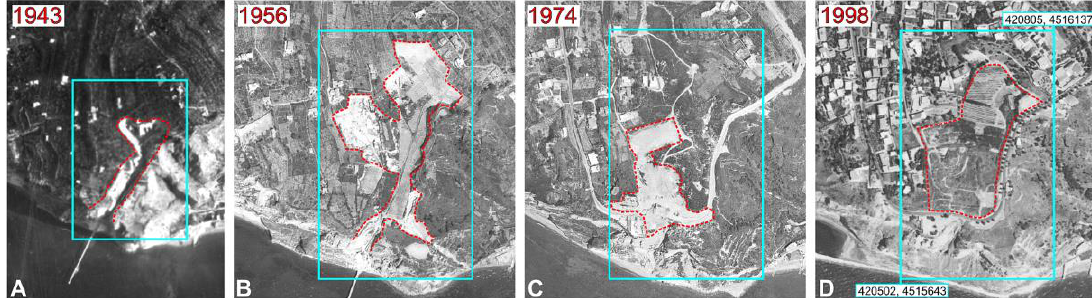
Figure 4. Comparison between aerial photos acquired by the Italian Military Geographic Institute in 1943 ( A ), 1956 ( B ), 1974 ( C ) and 1998 ( D ). Cyan polygons indicate the location of the investigated area. Dashed red line marks the limits of the quarry area. Coordinates are in the reference system ETRF 2000/UTM—zone 33 N.